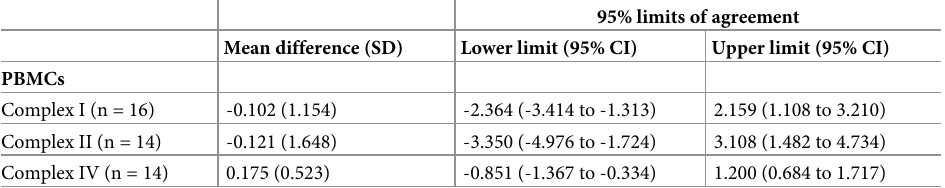
Table 4. Bland-Altman limits of agreement analysis between permeabilized muscle fibers and monocytes Z-